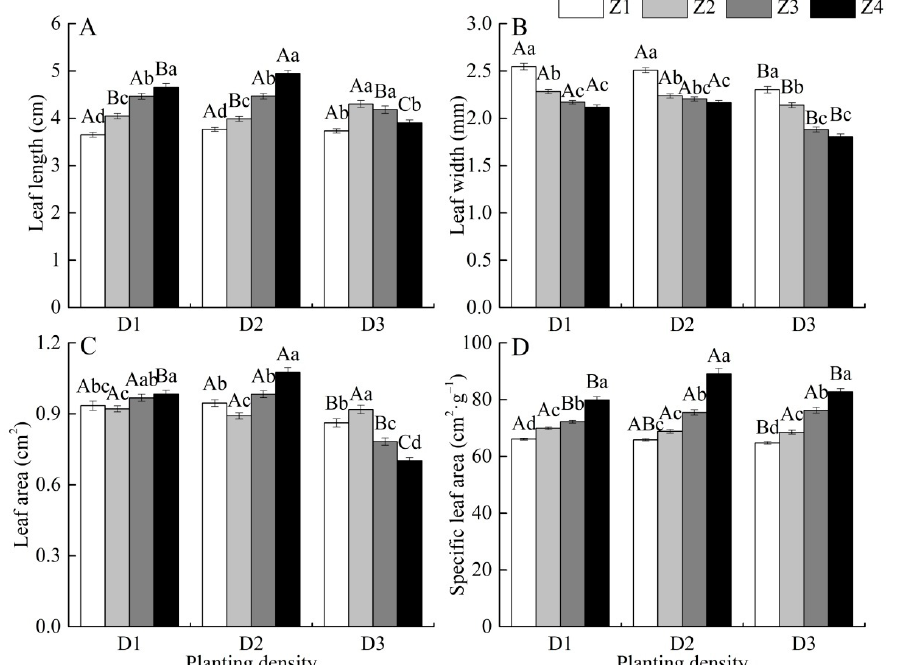
Figure 1. Leaf length ( A ), leaf width ( B ), leaf area ( C ), and specific leaf area ( D ) of C. lanceolata saplings under different planting densities (D1–D3). Bars are the mean values with standard error. Lowercase letters indicate significant differences among leaf position variations (Z1–Z4) at the same planting density; capital letters indicate significant differences among planting density variations at the same leaf position. D1 = low density, approximately 900 trees · ha − 1 , D2 = medium density, approximately 2505 trees · ha − 1 , D3 = high density, approximately 6660 trees · ha − 1 ; Z1 = first layer, Z2 = second layer, Z3 = third layer, and Z4 = fourth